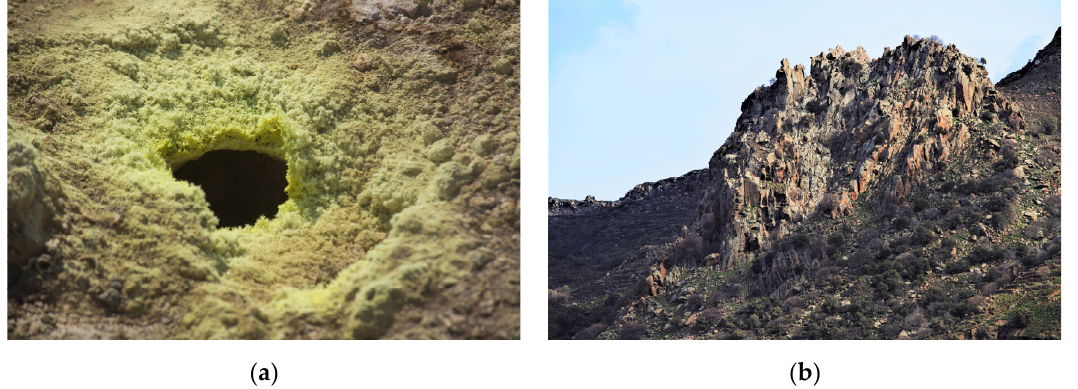
Figure 5. Nisyros is a prime example of an open volcanological laboratory, featuring a number of geological features of great educational and scientific interest: ( a ) Active fumarole within the bottom of Stefanos Crater, with characteristic sulfur deposits (crystals) formed around its vent. Approximate diameter 3–4 cm; ( b ) The Parletia Mound, one of the best examples of a rhyolitic lava neck formed between the two successive eruptions of the Caldera Eruptive Cycle of Nisyros [33]. It is exposed on the eastern caldera wall at an approximate altitude of 300 m a.s.l.